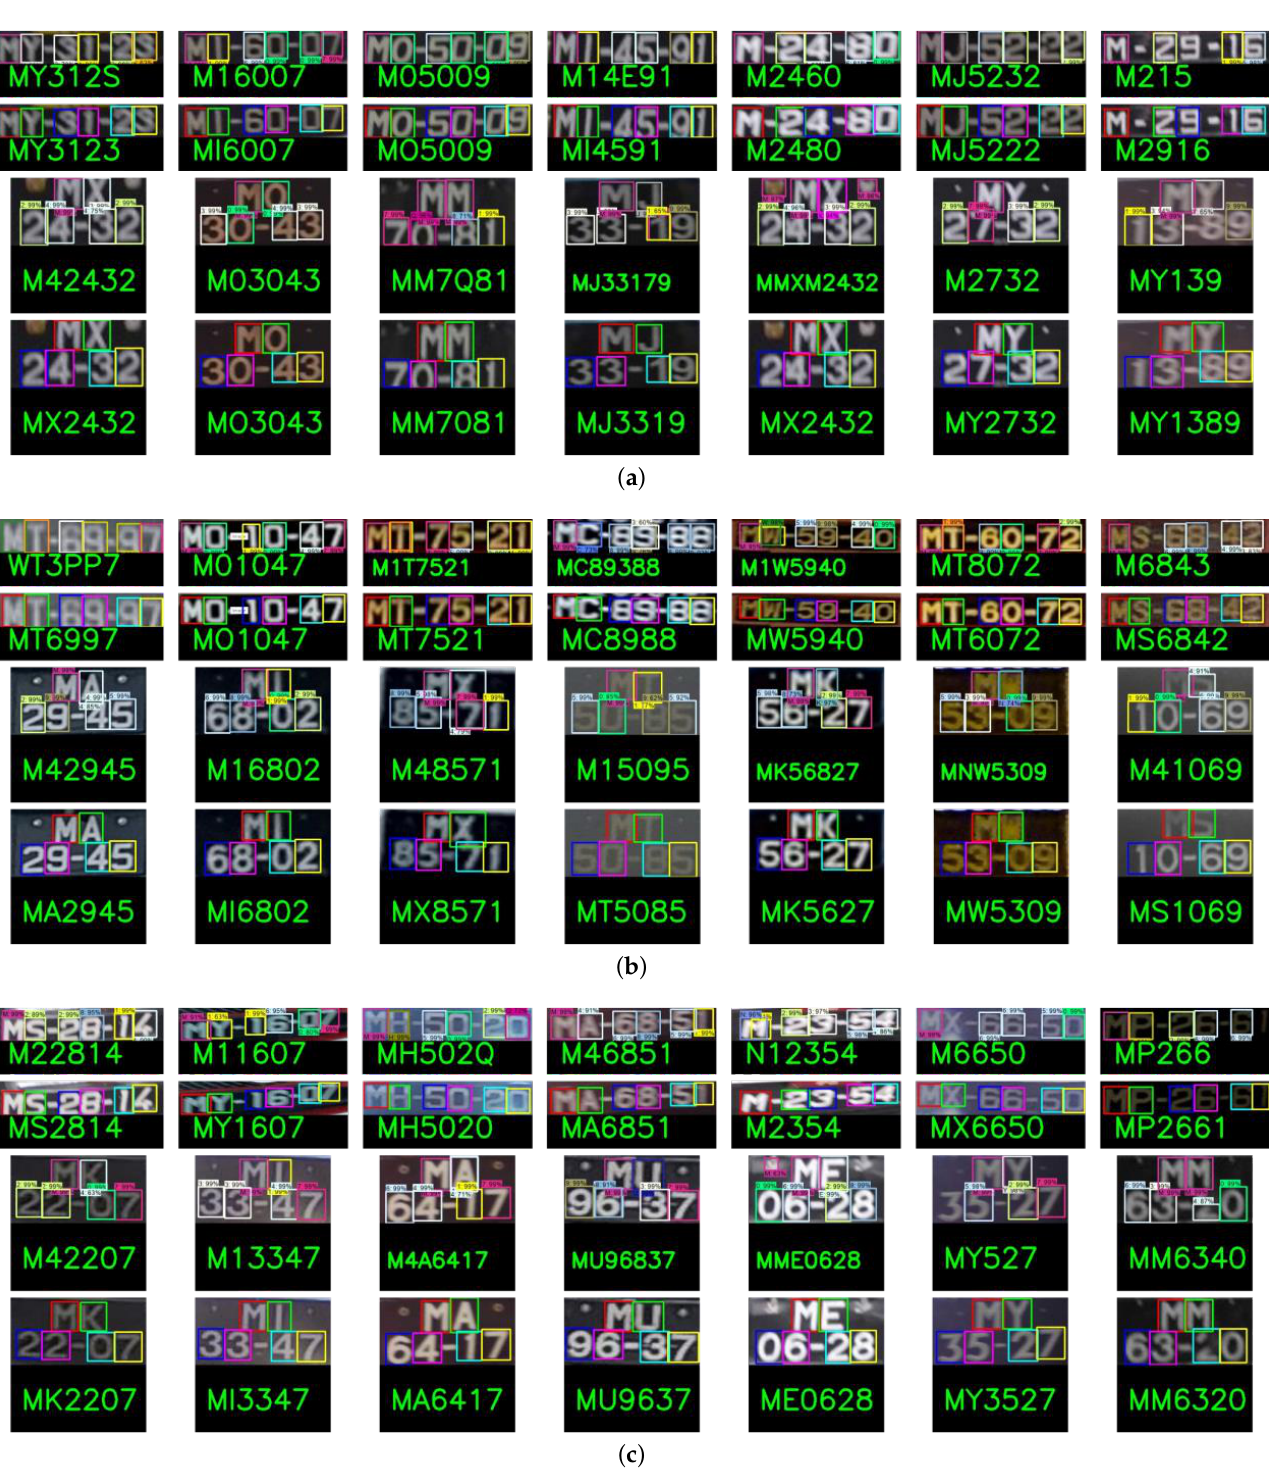
Figure 9. Some comparison of recognition results between ROI-based approach [33] and ours. Three sets are covered. The odd rows are generated by [33], and the even rows are generated by the proposed method. ( a ) Indoor; ( b ) outdoor; ( c )